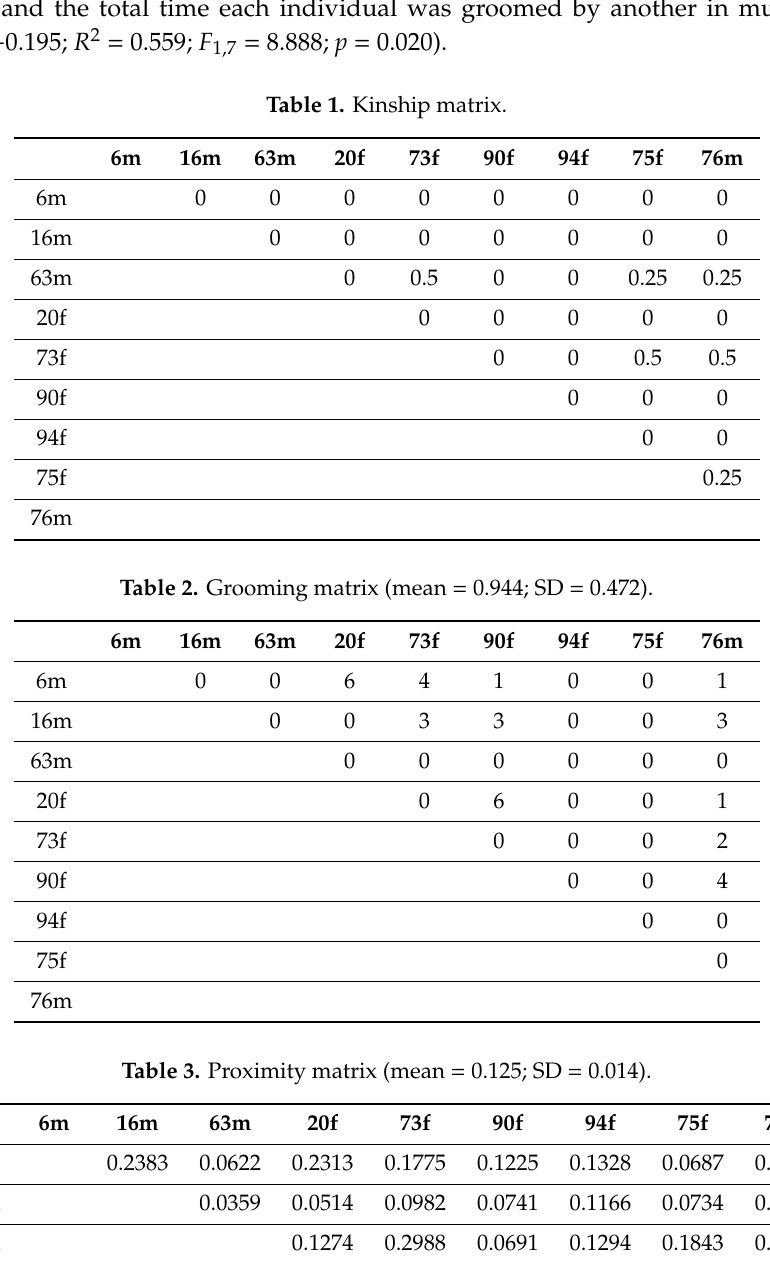
(Table S2: β = − 0.195; R 2 = 0.559; F 1,7 = 8.888; p = 0.020).